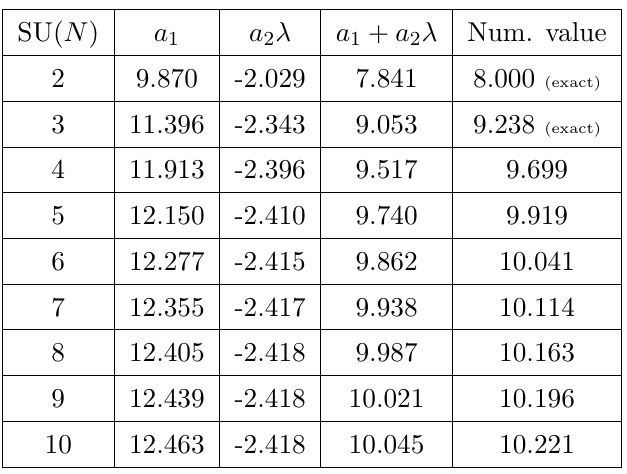
N 10), obtained using the (cid:20) (cid:20)